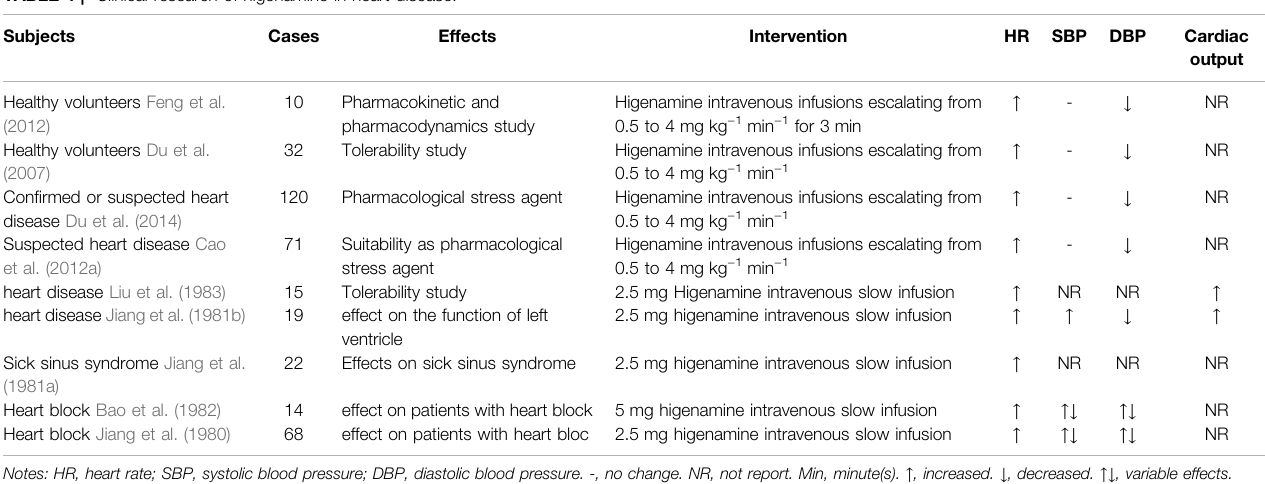
TABLE 4 | Clinical research of higenamine in heart disease. Subjects